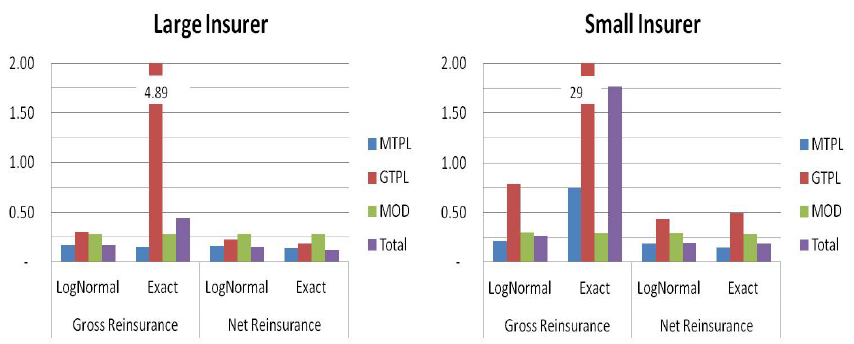
) + S · σ ( Z gross ) ). pre , LoB pre , LoB